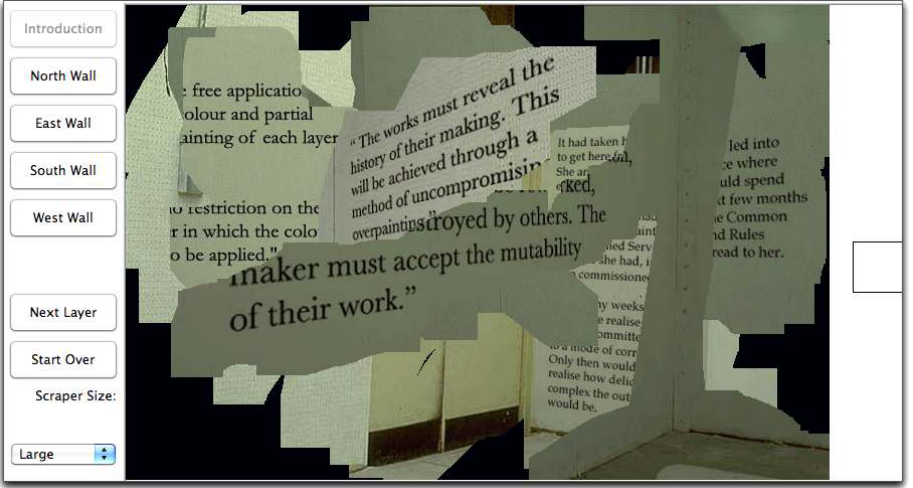
Figure 6: sample from Pentimento, by Jerome Fletcher, Geoffrey Olsen, Toby Holland